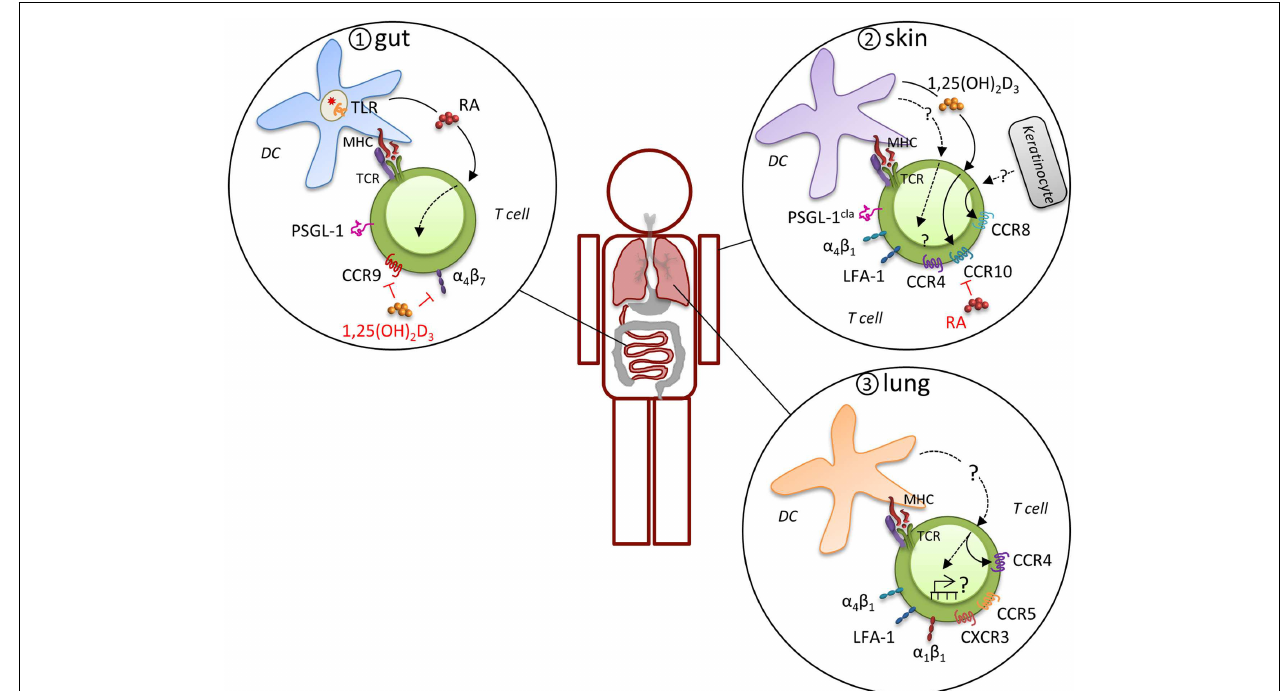
FIGURE 2 | Induction of tissue-specific MR profile . Expression of distinct MR combinations results in tissue-specific migration.T cells that are primed in gut-associated lymphoid tissues preferentially express functional PSGL-1, α β 4 7 , and CCR9, which support migration through the post capillary venules of the small intestine to enter the lamina propria and intraepithelial compartment (panel 1). CD103-expressing DC impart the intestinal homing signature onT cells during priming by expression of retinoic acid (RA) in response to microbiota-driven toll-like receptor (TLR) signaling. A different program of MR usage is induced during priming of naïveT cells in skin-draining LN (panel 2).T cells in the skin express the cutaneous lymphocyte antigen (CLA), an inducible carbohydrate modification of PSGL-1, CCR4, CCR8, CCR10, α 4 β 1 , and LFA-1, which mitigates their migration into the skin. Analogous